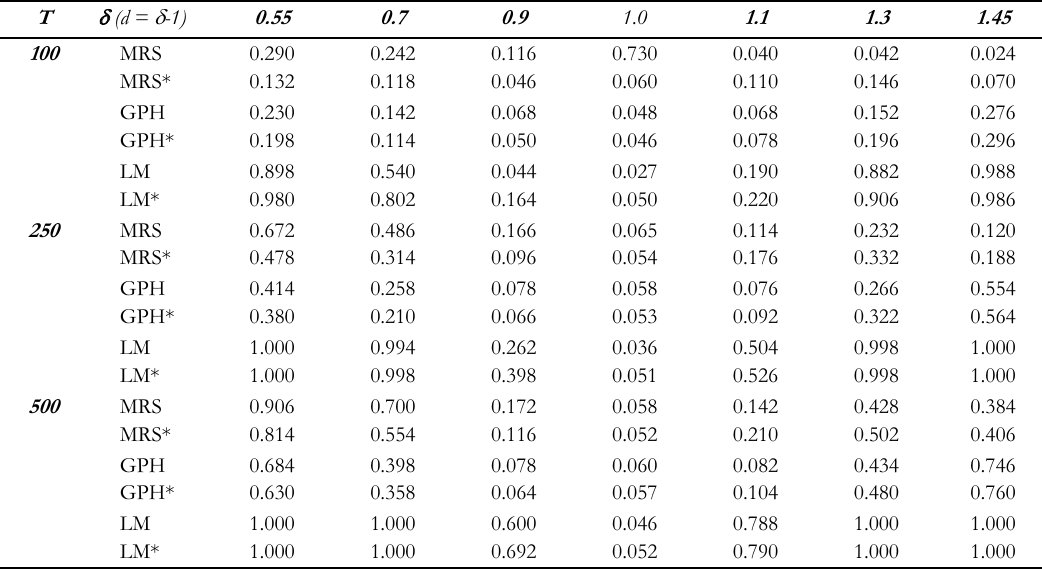
Estimate of power of unit root